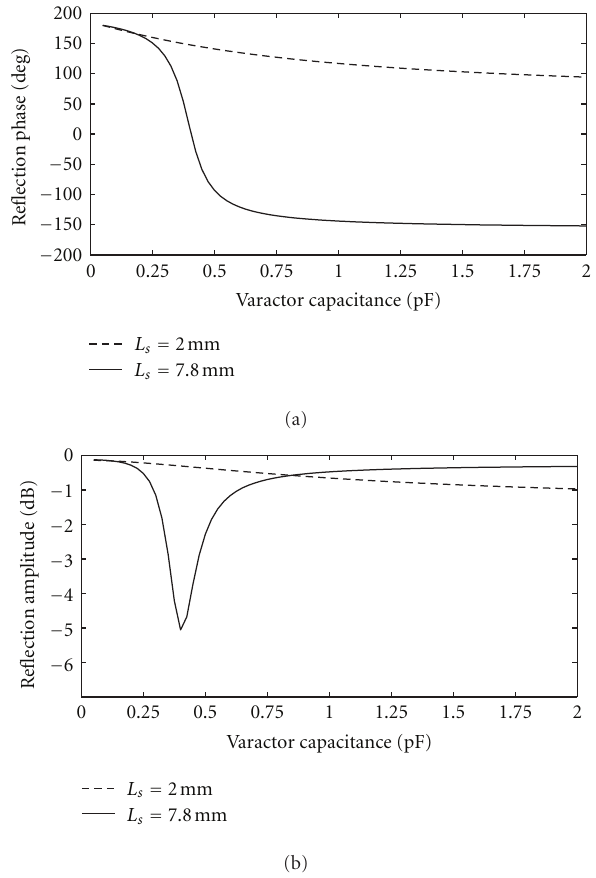
Figure 4: Reflectarray structure scheme—(a) aperture-coupled array; (b) array illuminated by the feed.